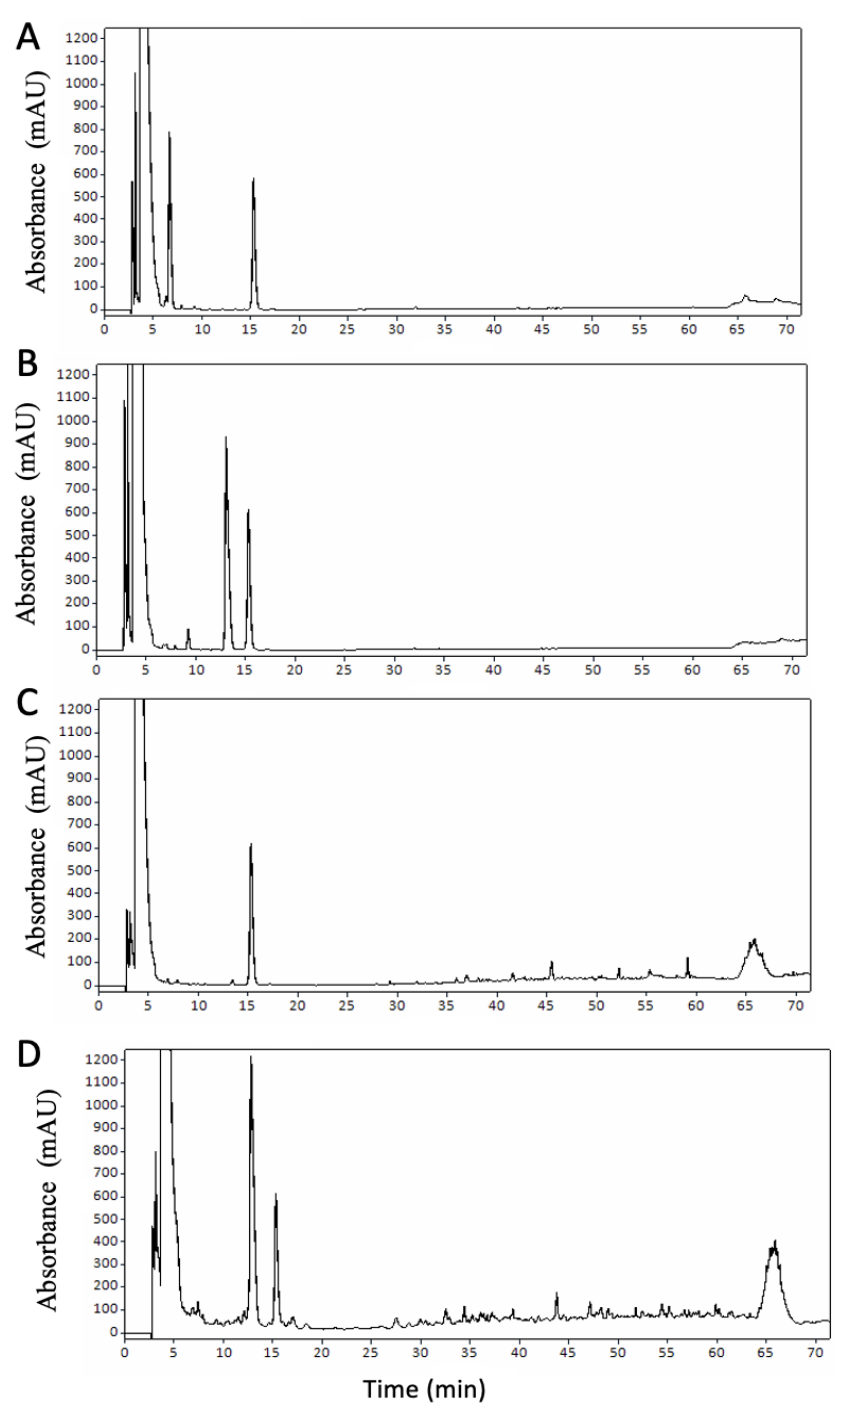
Figure 1. RP-HPLC chromatograms of 12% TCA soluble fraction of infant formula (IF) samples; ( A ) B-IF (bovine IF), ( B ) C-IF (caprine IF), ( C ) S-IF (soy IF), ( D ) R-IF (rice IF).